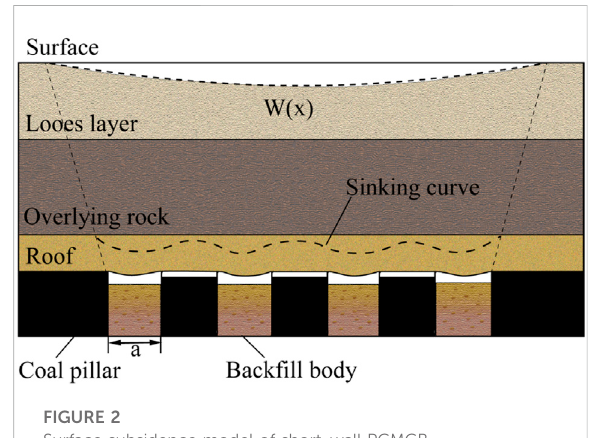
FIGURE 1 Diagram of the short-wall PCMCB system.